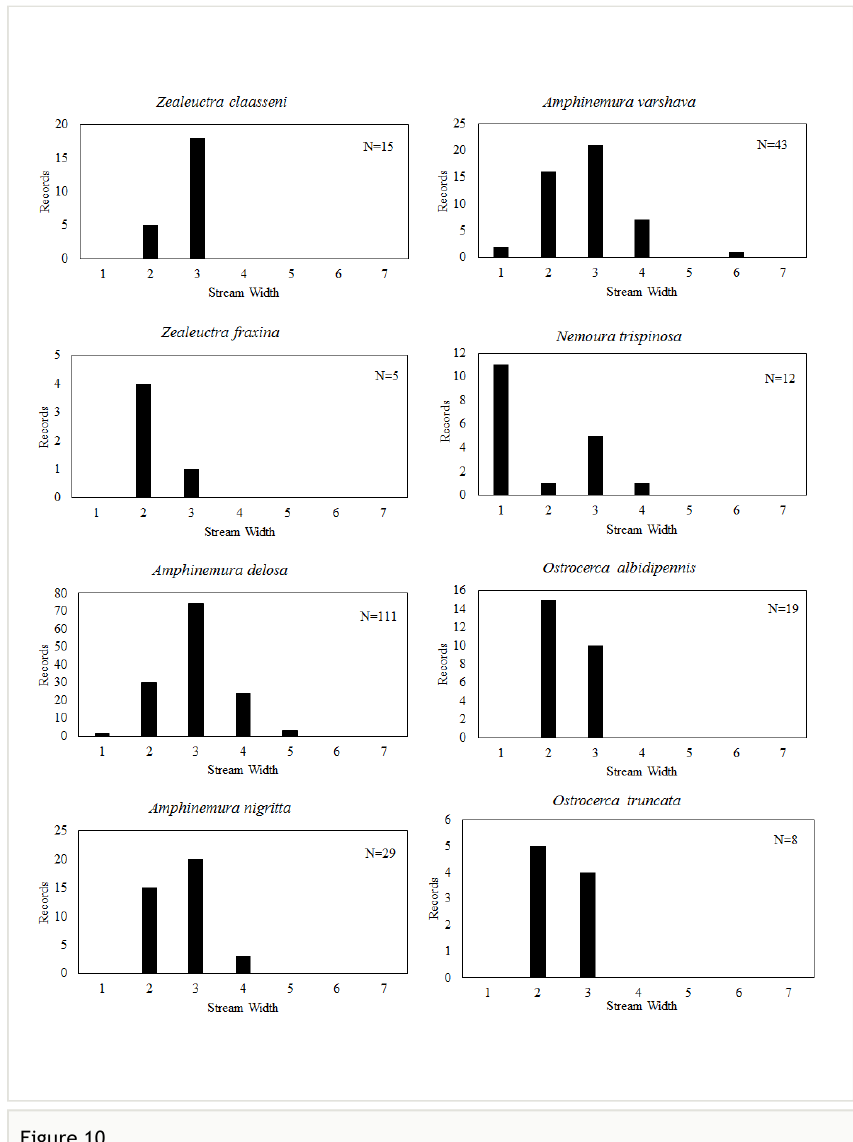
Figure 10. Stream width categories occupied by Nemouridae and Taeniopterygidae species in Ohio. Stream width categories: 1=seep, 2=1-2 m, 3=3-10 m, 4=11=30 m, 5=31-60 m, 6=>60